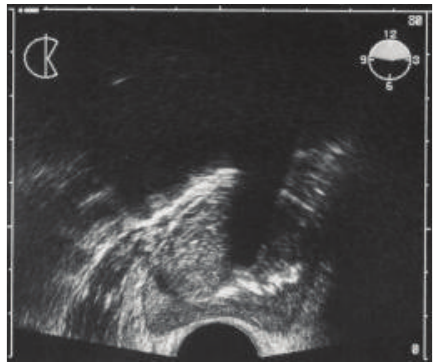
Figure 3: Transrectal ultrasound: hypoechoic lesion posterior and cranial to the prostate.